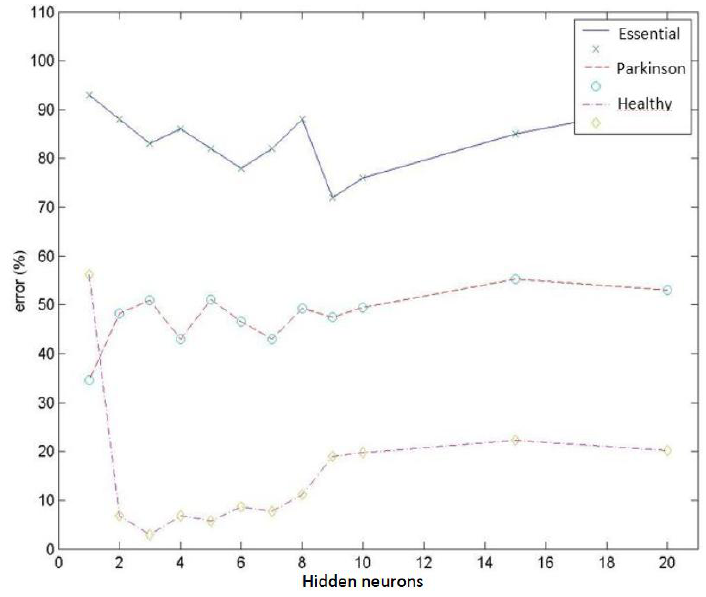
Figure 12. Error distribution for each type of pathology obtained using HOS